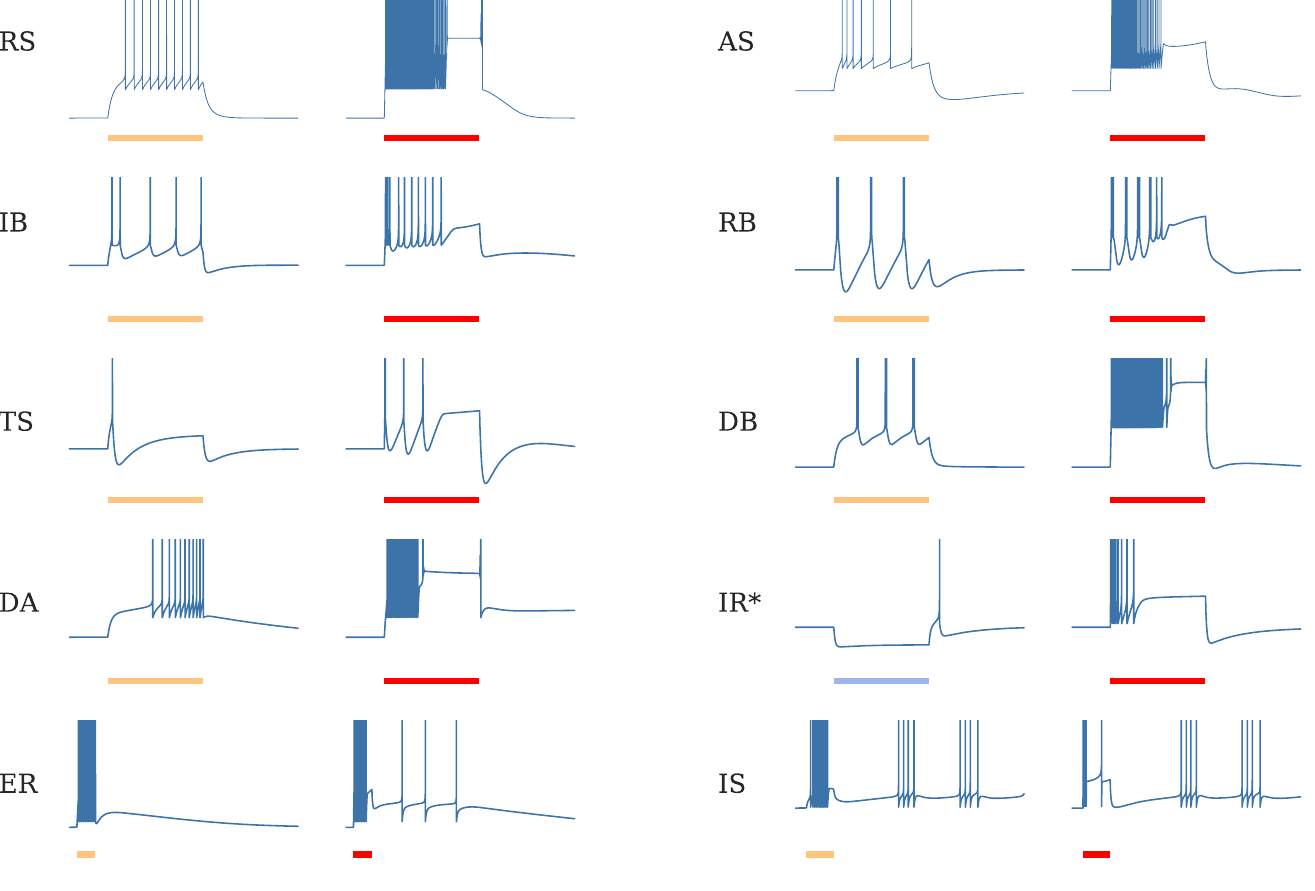
Fig 6. Typical dynamics of the mAdExp model with different parameter settings in response to current steps given by the scale bars—500 ms for all entries—In yellow to mark lower excitation, red to mark higher excitation, blue bar and asterisk on IR to mark inhibitory current. The behaviors include regular spiking ( RS ), adaptive spiking ( AS ), initial burst ( IB ), regular bursting ( RB ), transient spiking ( TS ), delayed bursting ( DB ), and delayed accelerating ( DA ). Similar responses to the lower (yellow) currents can be achieved by the original AdExp model. However, each of these dynamics now comes with an “energy-depleted” state for high input current (red), associated to a depolarization block (responses associated to red bars), that cannot be captured by AdExp model. In addition to these standard behaviors, dynamical repertoire of the mAdExp neuron also includes a different mechanism for post-inhibitory rebound spiking ( IR ), and can display post-excitatory rebound ( ER ) or intermittent spiking dynamics ( IS ). See S3 Table for detailed